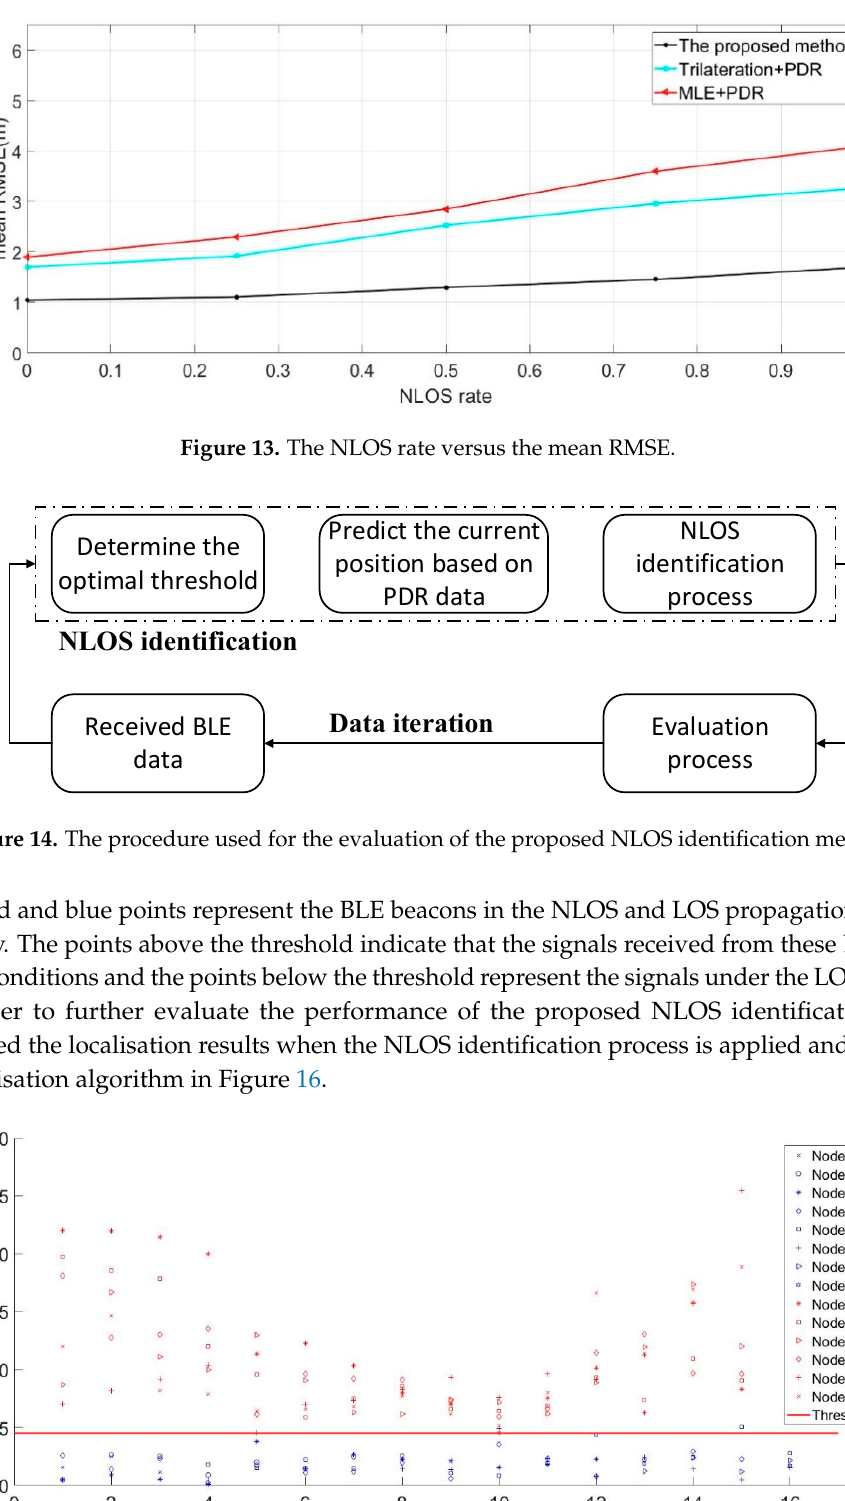
Figure 16. The results of the proposed localisation algorithm when NLOS identification is applied or not. 5. Conclusions and Future Work In this paper, we proposed a novel probabilistic position selection algorithm based on the RSSI and PDR. In order to better filter out the particles and mitigate the impact of the NLOS condition on localisation performance, a low-complexity RSSI-based identification approach is proposed to identify the change in the channel situation between NLOS and LOS. This study assessed the developed algorithm in a multitude of simulations. The trilateration + PDR and MLE + PDR were subjected to the same testbeds to serve as a benchmark for comparison with the proposed algorithm. A sample data set was collected within our indoor test environment and used as a base to generate computationally simulated data to better validate the developed algorithm with various site conditions. In order to demonstrate the reliability and robustness of PPSA, the validation tests included different NLOS rates of signal propagation by varying the quality of the BLE signal propagation condition. Through comparison with the trilateration + PDR and MLE + PDR methods, we verified that the proposed algorithm outperforms the other methods in terms of the localisation accuracy and that it can better overcome the NLOS errors. The benefit of the PPSA is the ability to filter the signals in NLOS and further process the positioning estimation by giving more significance to the relatively reliable signals. An underlying assumption in this is that there are at least a few BLE beacons that generate reliable signals. For this to be guaranteed in an indoor environment, the deployment of the BLE beacons needs to be such that no areas exist where none of the beacons is in near proximity; in fact, PPSA is not a concern only for this BLE system, but also for all other systems that use RSSI-based technology. However, there are two limitations of the proposed PPSA. First, in